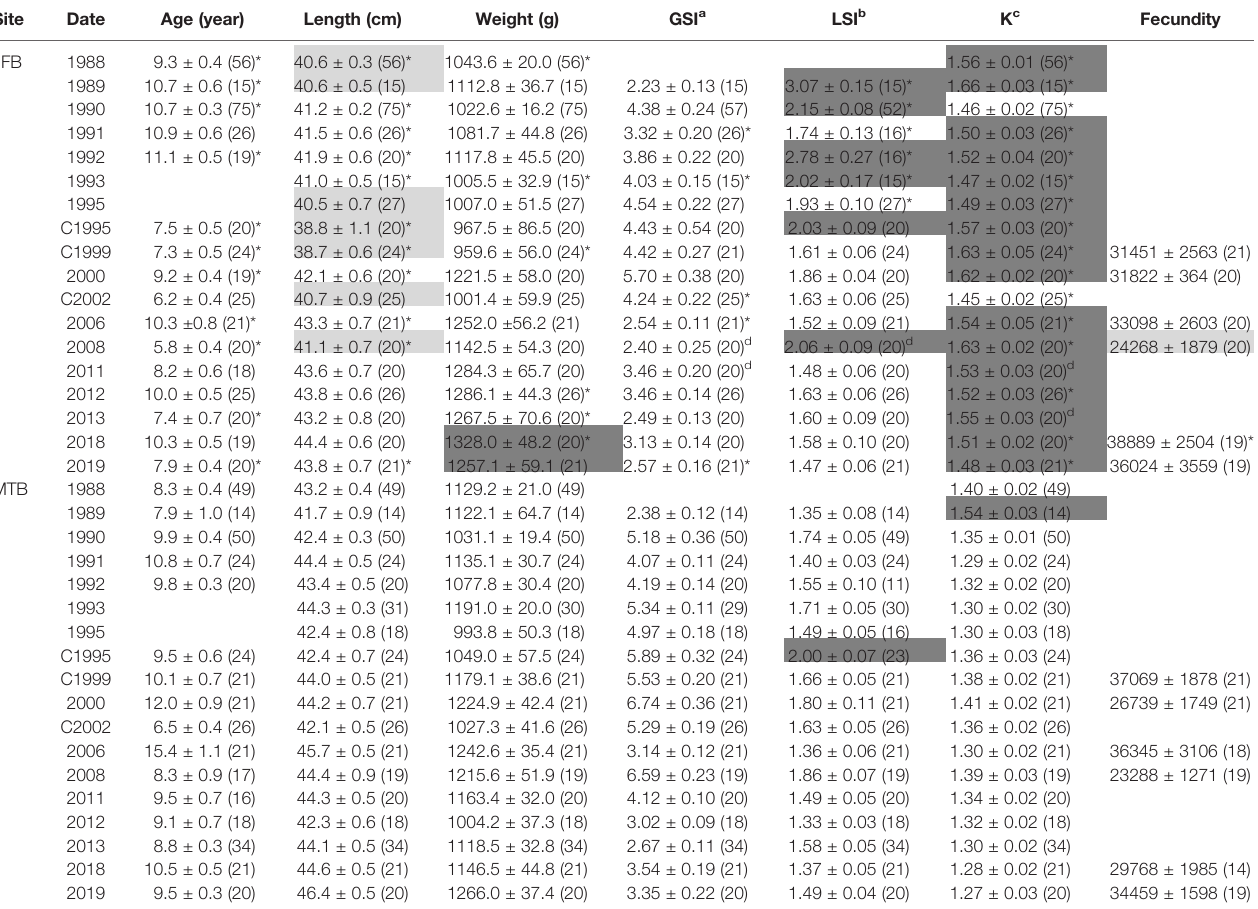
Values are reported as mean ± SE (n). Shaded cells are either below (light grey) or above (dark grey) normal range for Mountain Bay. *Signi fi cant difference between sites (p ≤ 0.05) within years; a GSI = 100* (gonad weight/body weight); b LSI = 100* (liver weight/body weight); c K = 100*(weight/length 3 ); d Represents an interaction between sites; All data before 2008 published in Bowron et al.